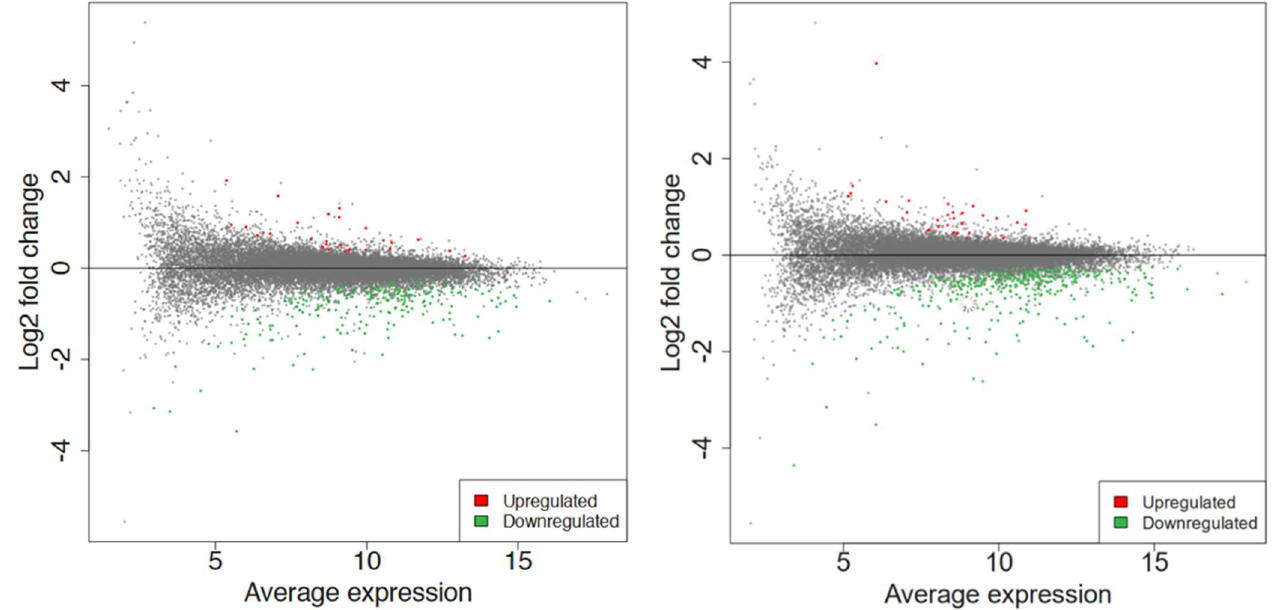
Figure 4. The MA plot shows the relationship between the average normalized expression on the x−axis and the significance of the differential expression test expressed as log2FC on the y−axis for each gene in the genome. It illustrates the number of DEGs for 60 s ( left ) and 80 s ( right ). Gray dots represent the genes that are not significantly differentially expressed, while red and green dots are the genes that are significantly up− and downregulated, respectively, based on their p −values (not shown here).